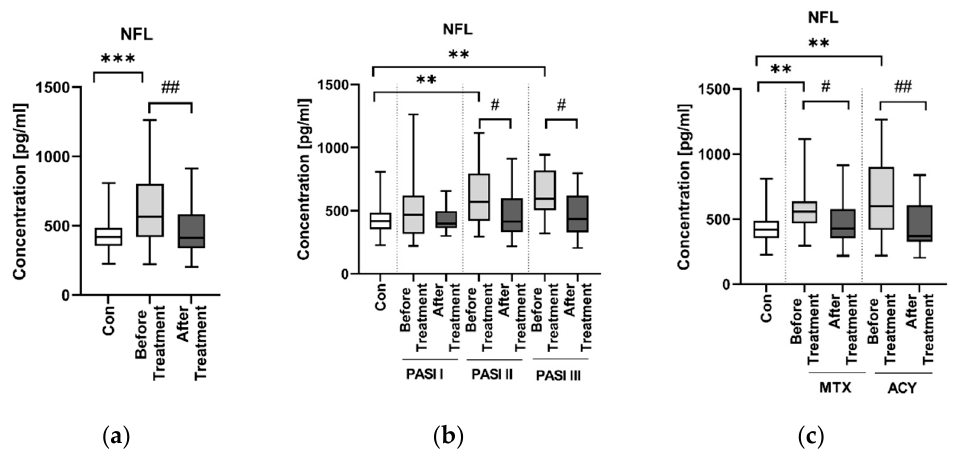
Figure 6. Concentration of NFL in patients (before and after the treatments) and controls ( a ); concentrations of NFL in patients (before and after the treatment) according to PASI division, as well as in controls ( b ); NFL concentrations in patients (before and after the treatment with methotrexate, MTX, or acitretin, ACY) and controls ( c ). ***/** means a statistically significant difference between the patients after the treatment and controls with p < 0.001/ p < 0.01. ##/# means a statistically significant difference between the patients before and after the treatment with p < 0.01/ p < 0.05.